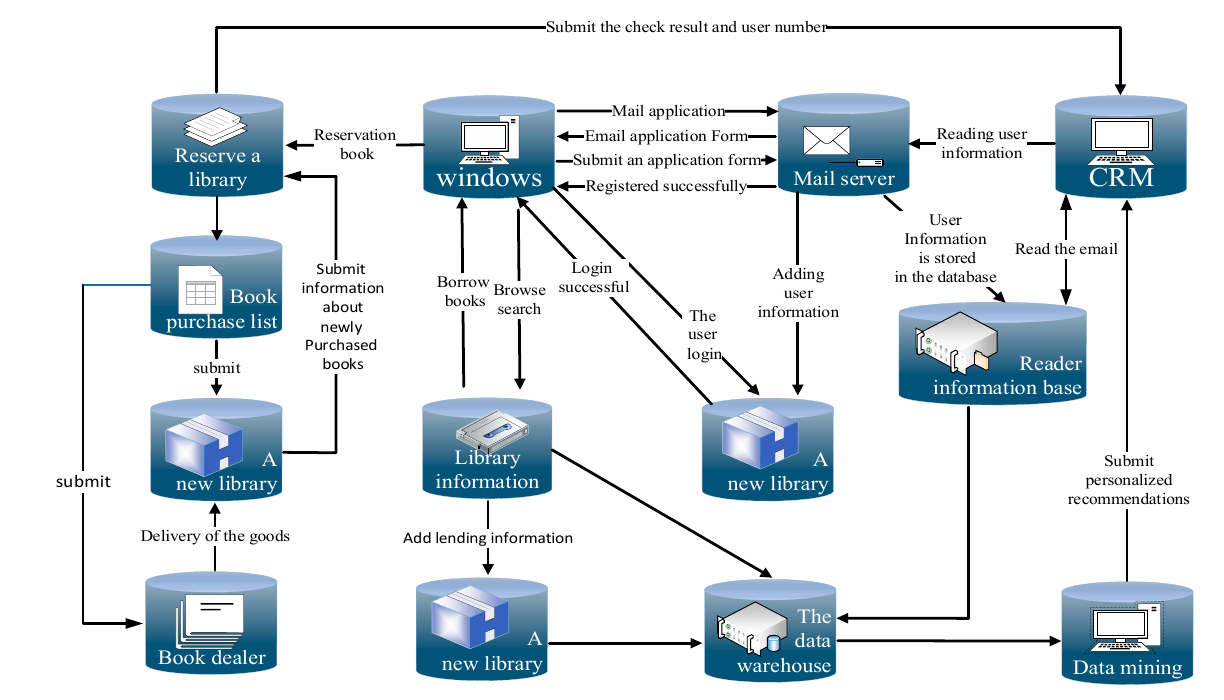
Figure 5. Library business process.